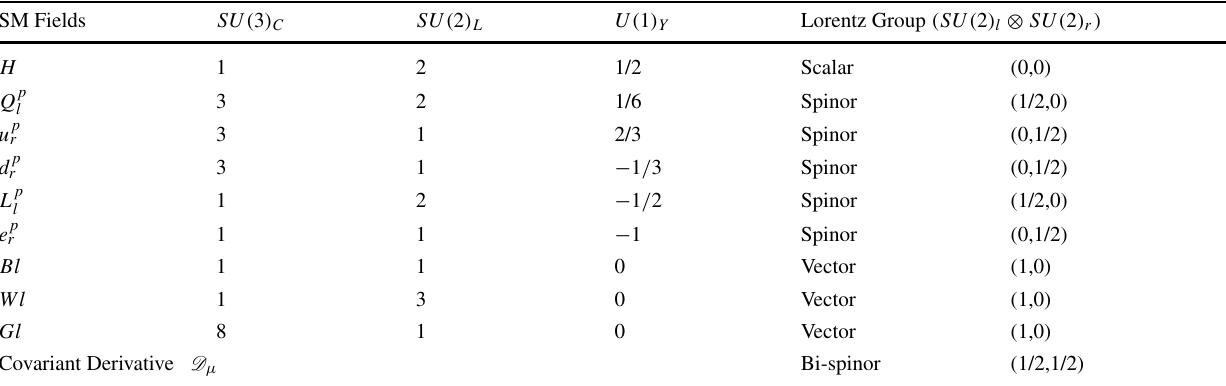
Table 17 Quantum numbers of fields under the SM gauge groups and Lorentz group. I = 1,2,3; a = 1,2,…,8; p = 1,2,3 denotes the flavor index. The color and isospin indices have been suppressed. l and r denote the chirality, i.e., the left or right handedness of the field SM